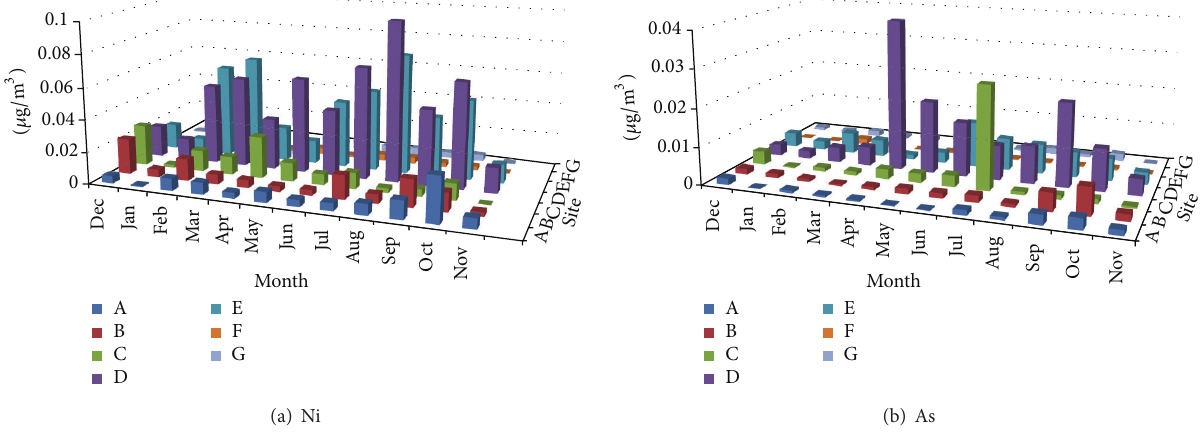
Figure 5: Spatial and temporal distribution of Ni and